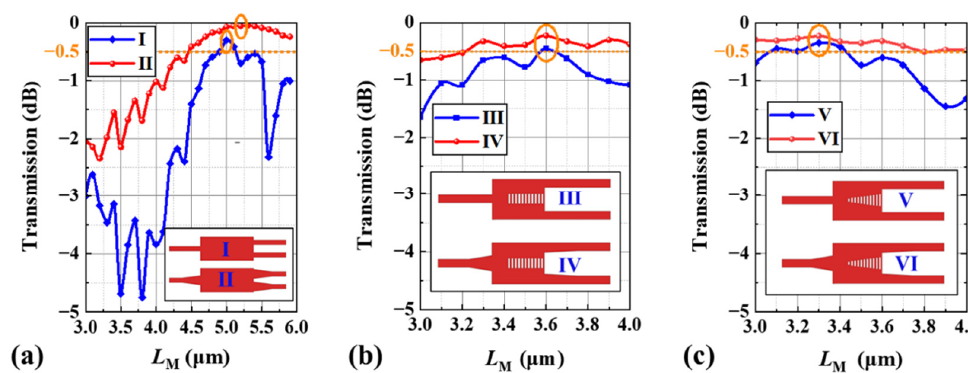
Figure 3. Transmission of several typical silicon-based MMI power splitters as a function of their respective MMI lengths L M . ( a ) I and II represent the conventional MMI structure without and with input/output tapers, respectively. ( b ) III and IV represent the MMI structure embedded with a uniform SWG waveguide without and with input/output tapers, respectively. ( c ) V and VI represent the MMI structure embedded with an inverse-tapered SWG waveguide without and with input/output tapers, respectively.